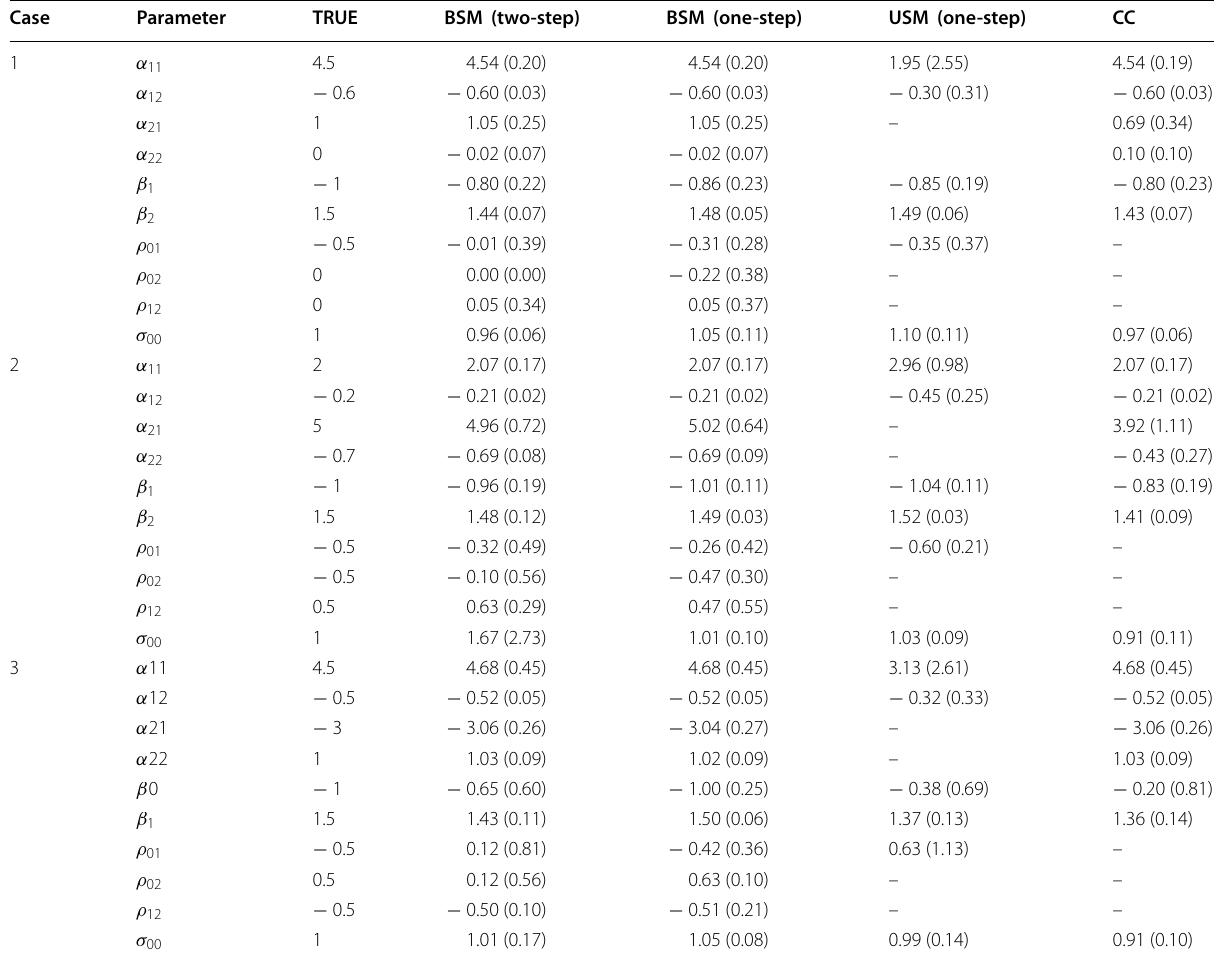
Table 1 Estimates of the parameters with mean squared errors (in parentheses) with the normality assumption for errors